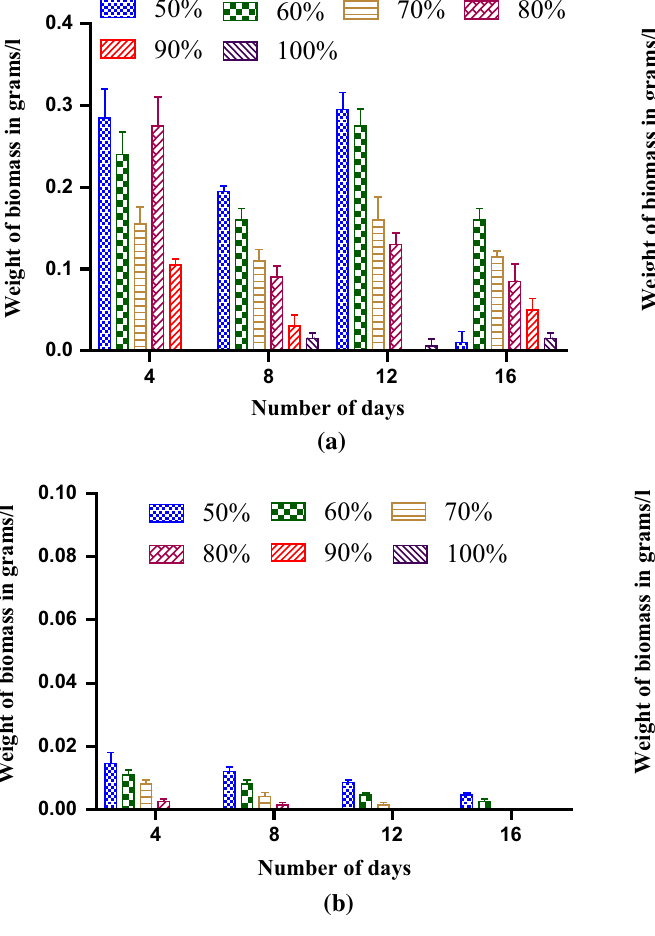
Fig. 4 Treatment of different effluent concentration of BHEL area using a Chlorella sp. SRD3 and b Oscillatoria sp. SRD2